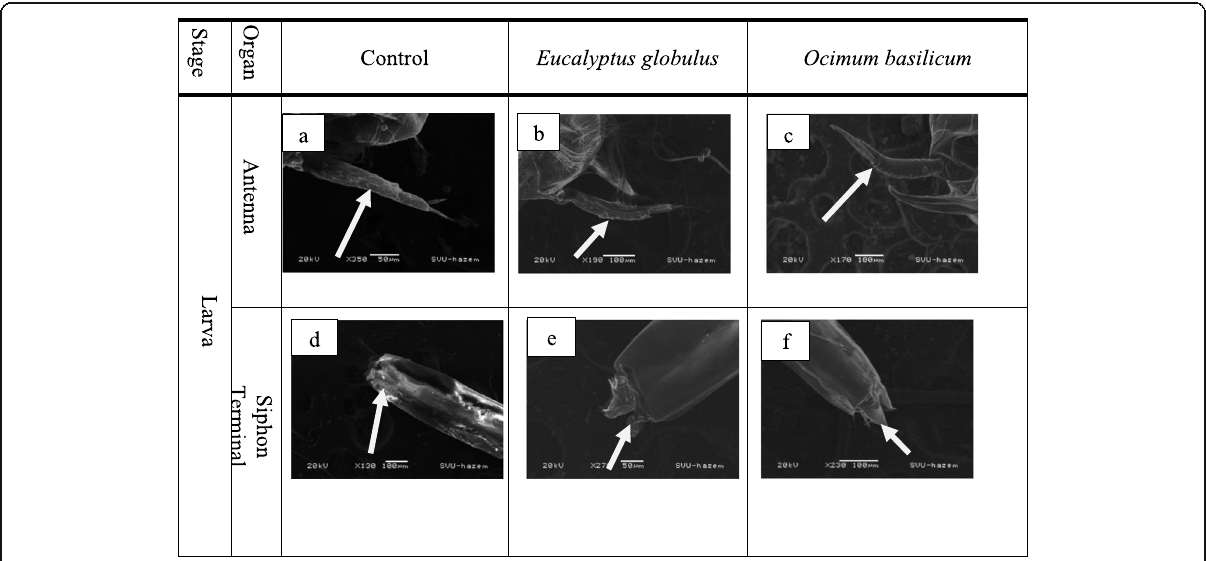
Fig. 3 Scanning electron microscopic (SEM) of the larval antennae and siphons of Culex pipiens under no smoke, smoke of Eucalyptus globulus , and smoke of Ocimum